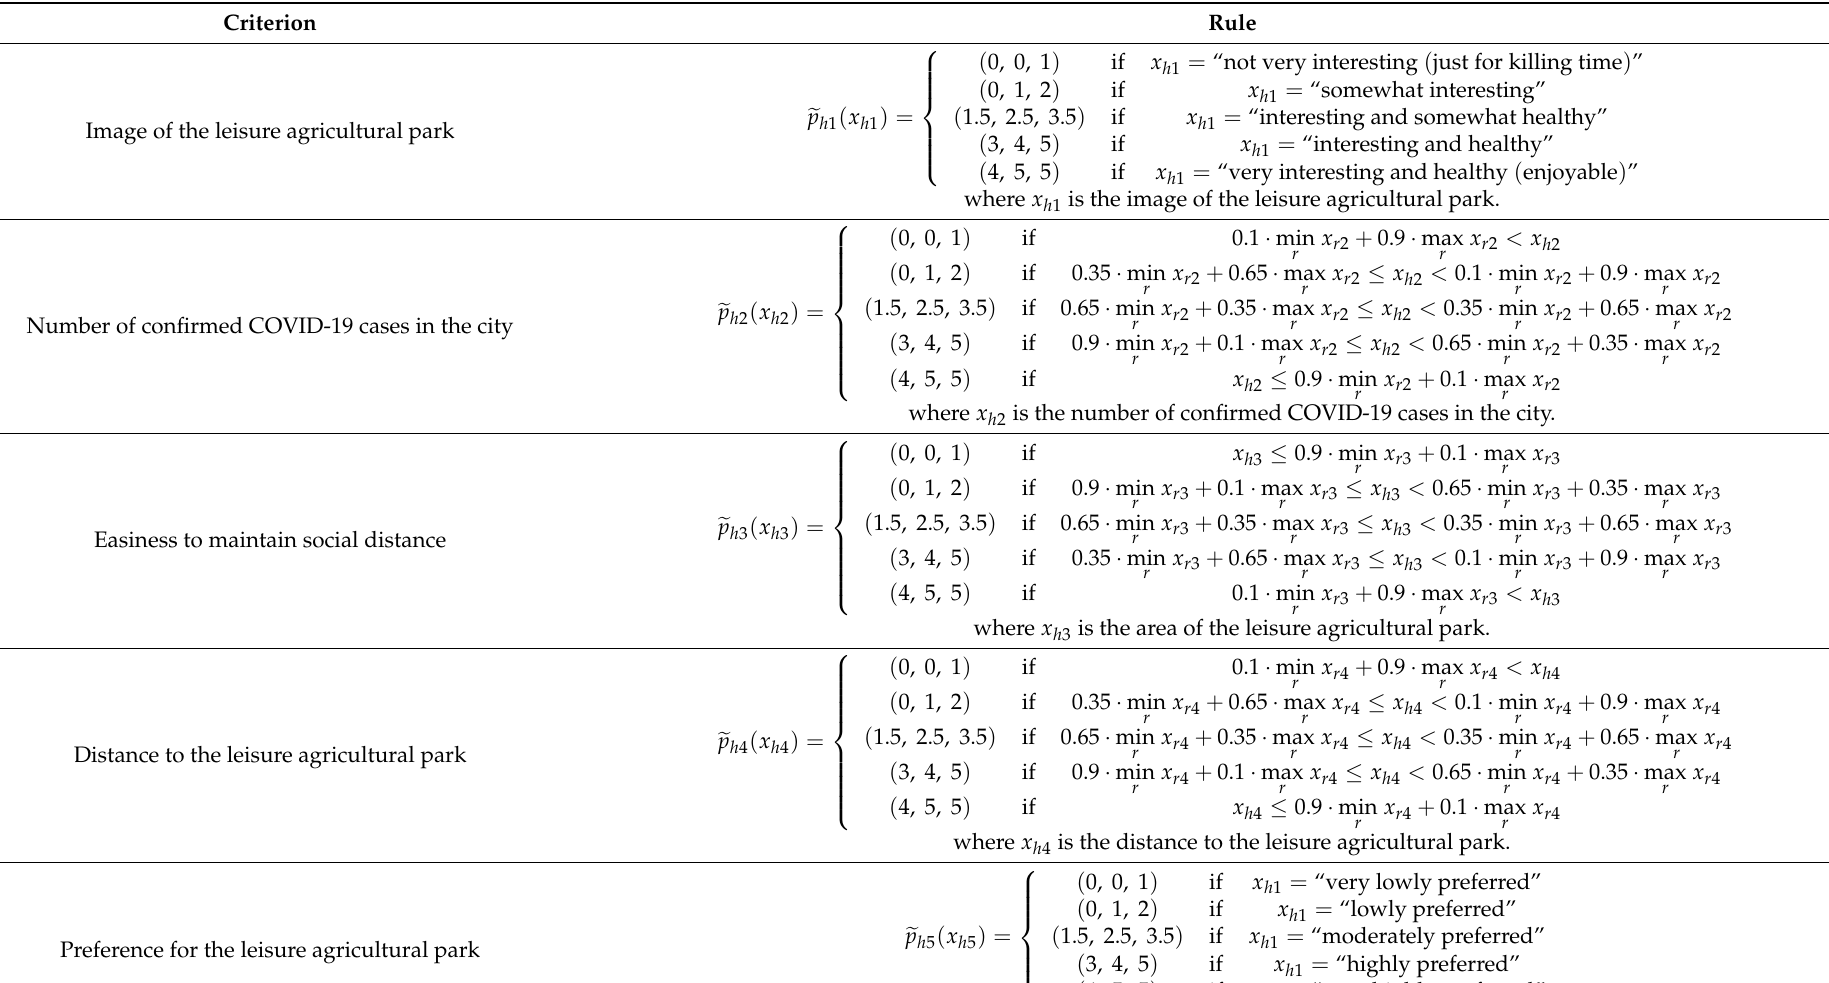
Table 3. Rules for evaluating the performance of a leisure agricultural